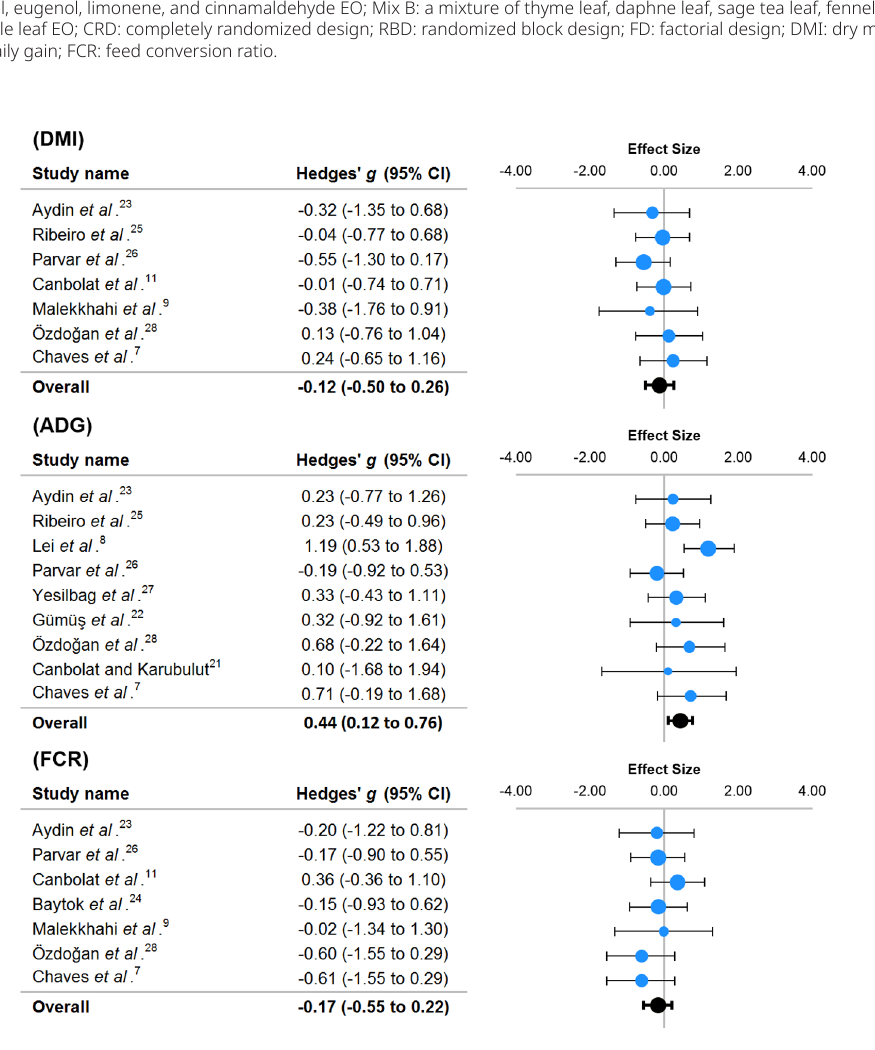
Figure 2. Forest plot of the effect of essential oil supplementation on growth response of small ruminants. DMI: dry matter intake; ADG: average daily gain; FCR: feed conversion